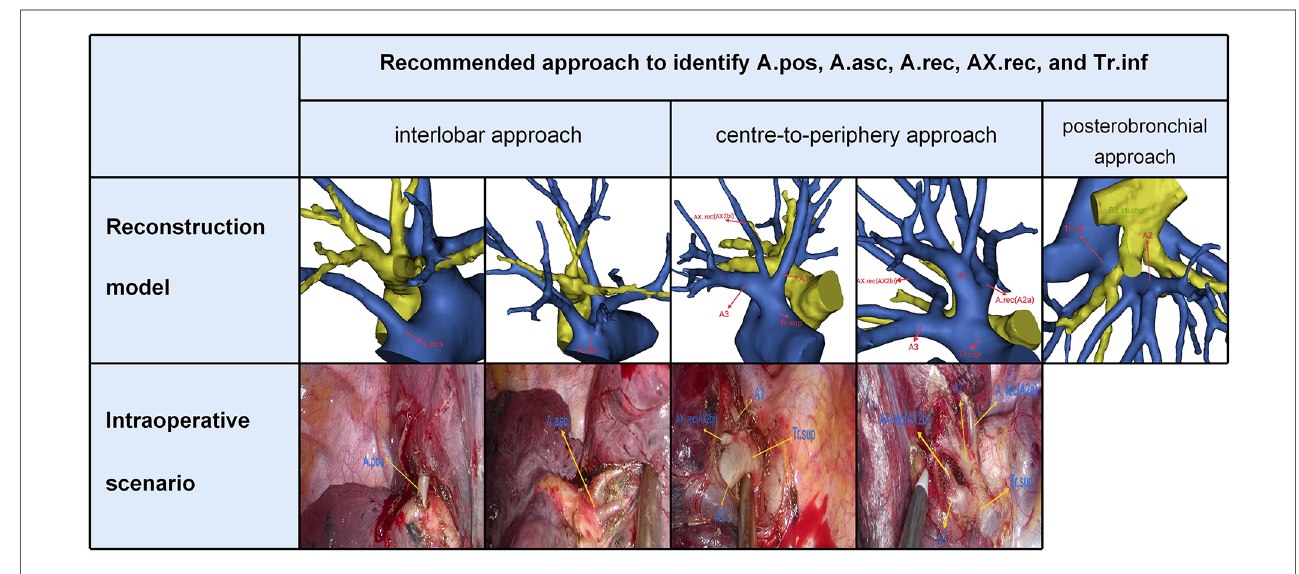
FIGURE 6 Three basic approaches to identify A.pos, A.asc, A.rec, AX.rec, and Tr.inf.